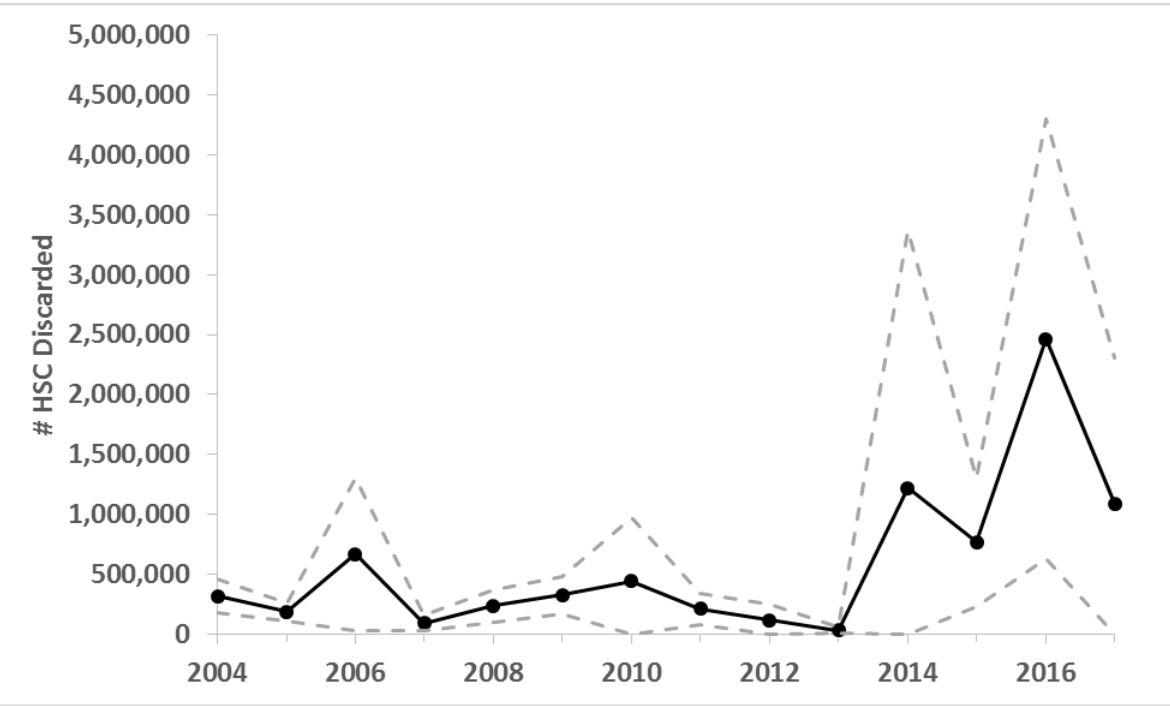
Figure 18. Estimated number of horseshoe crabs discarded from dredges in the Delaware Bay region, 2004-2017, with 95% confidence intervals.